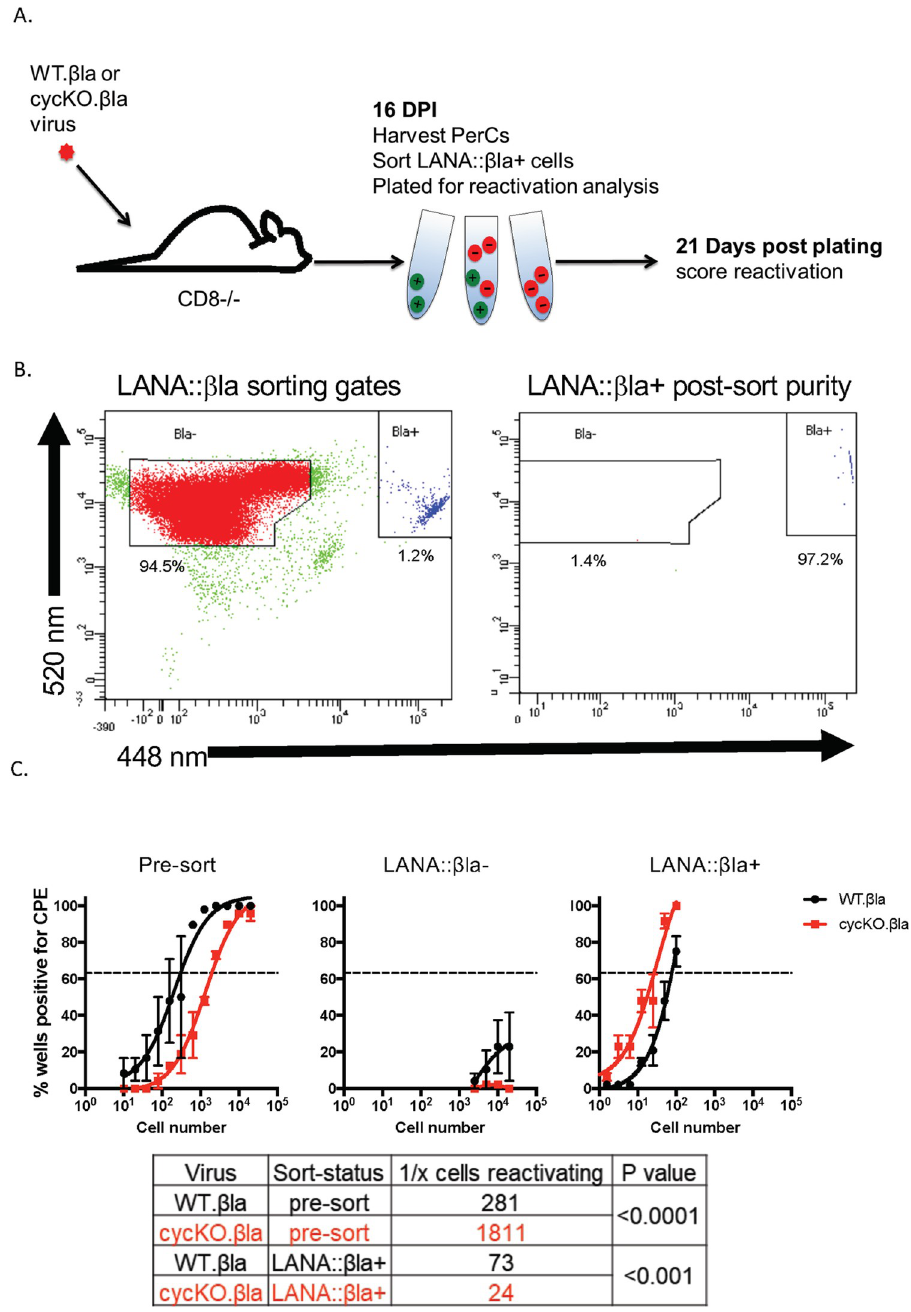
Fig 8. The viral cyclin is dispensable for reactivation in latently infected cells that express LANA:: β la. (A) Experiment schematic. CD8-/- mice were infected via IP injection with WT. β la or cycKO. β la viruses and peritoneal cells were harvested at 16 dpi. Cells were stained for β -lactamase activity and LANA:: β la+ cells were sorted by FACS. (B) Gating strategy of LANA:: β la sort (left) and purity of post-sort WT. β la infected LANA:: β la+ cells (right). LANA:: β la+ cells are located in the upper right polygon and LANA:: β la- cells are located in the upper left polygon. The percent of events within each gate is indicated below the gate, with data showing that > 97% of purified cells were LANA:: β la + cells. (C) WT. β la (black) and cycKO. β la (red) infected pre-sorted (left), LANA:: β la- (middle), and LANA:: β la+ (right) cells were subjected to limiting-dilution reactivation analysis. Reactivation was measured 21 days after plating sorted and pre-sorted cells on permissive MEFs. Linear regression with comparison of the LogEC(63.2) found that the frequency of ex vivo reactivation was higher in pre-sorted WT. β la than in cycKO. β la infected cells, whereas WT and cycKO cells had comparable reactivation when analyzed in sorted, LANA:: β la+ cells. n = 2 independent experiments